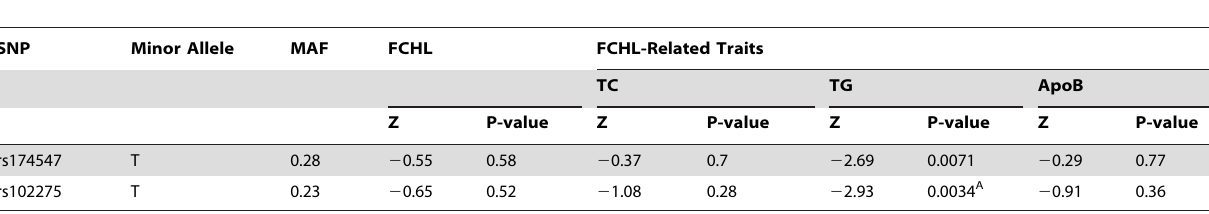
Table 6. Replication of association evidence for FADS1-2-3 locus in Mexican FCHL families with qualitative lipid traits.